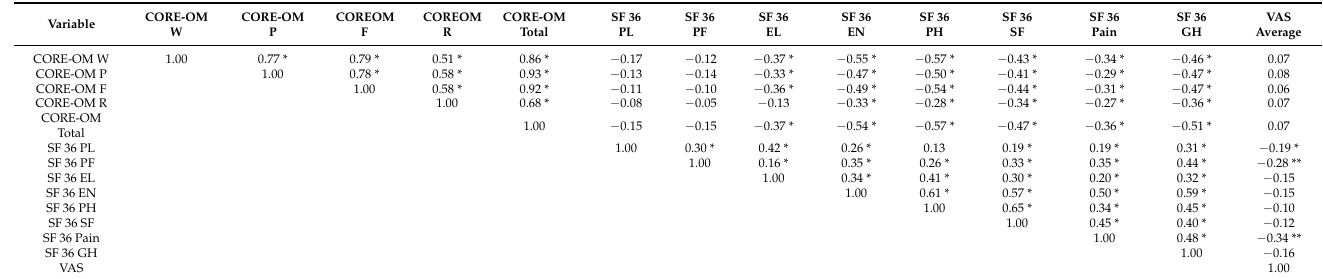
Table 4. Correlations between the CORE-OM dimensions, the subscales of the SF-36, and pain intensity ( n =